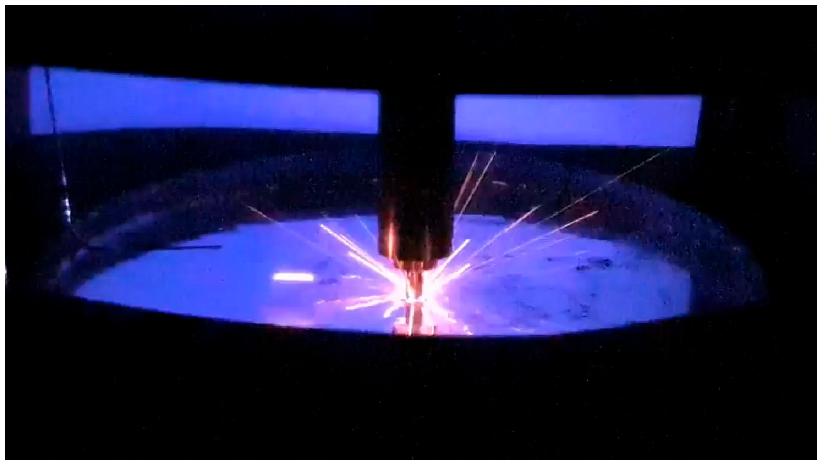
Figure 13. Appearing of the sparkle above a liquid surface at the current 500